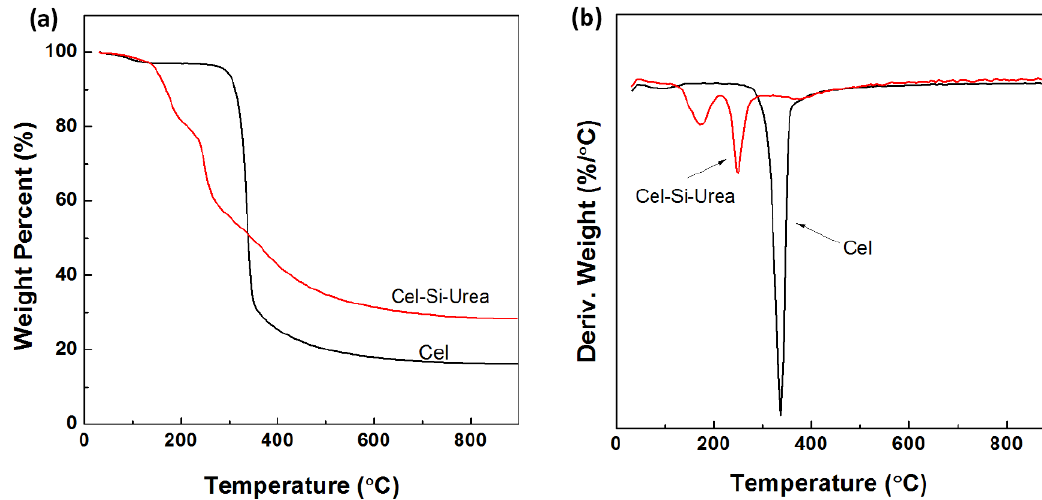
Figure 3. Thermogravimetric analysis (TGA) ( a ) and derivative thermogravimetric analysis (DTG) ( b ) curves of the pristine cellulose (Cel) and the urea-terminated silane-modified cellulose (Cel-Si-Urea).